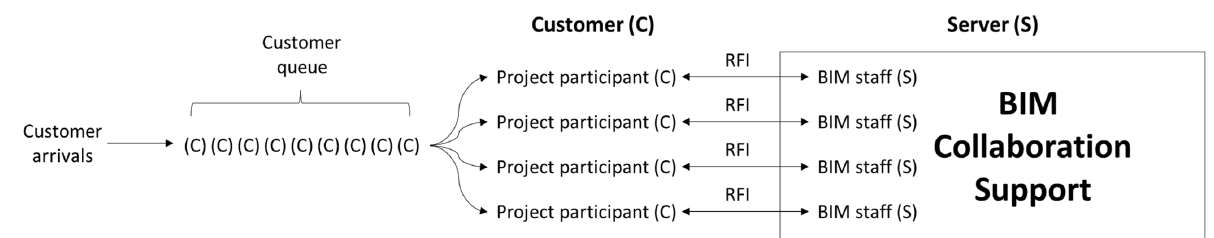
Figure 2. Queuing system supporting BIM collaboration.